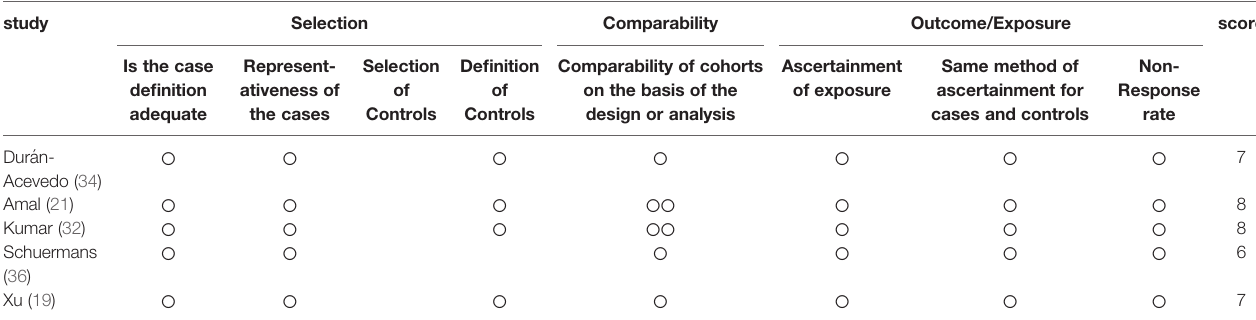
TABLE 5 | Newcastle – Ottawa Scale scores.